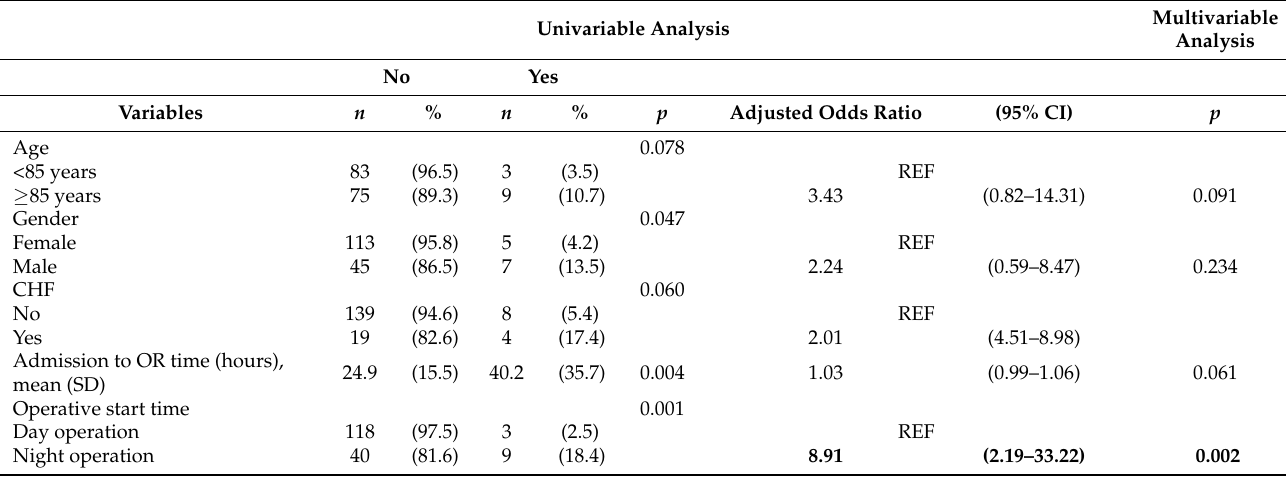
Table 3. Univariable and Multivariable Analysis for 90-Day